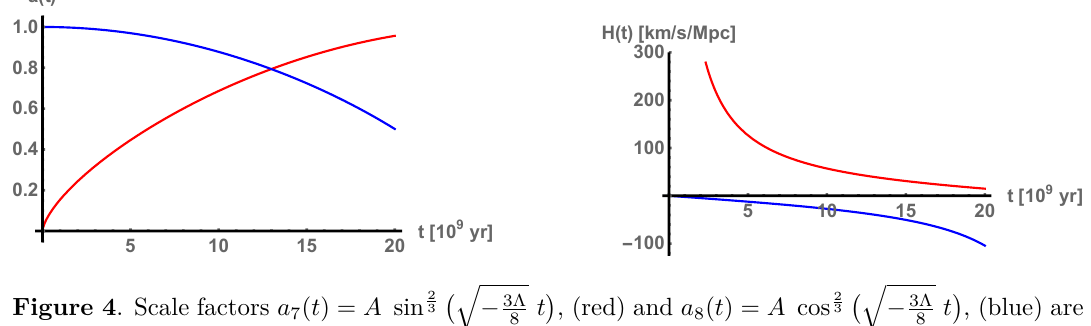
Figure 4 . Scale factors a 7 ( t ) = A sin 2 3 on the left side. The corresponding Hubble parameters H